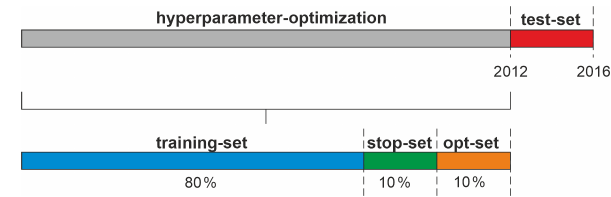
Figure 2. Data splitting scheme: each time series is split into four parts for training, early stopping, HP optimization, and testing. The latter is fixed to the period years 2012 to 2016 for all wells; the former three parts depend on the available time series